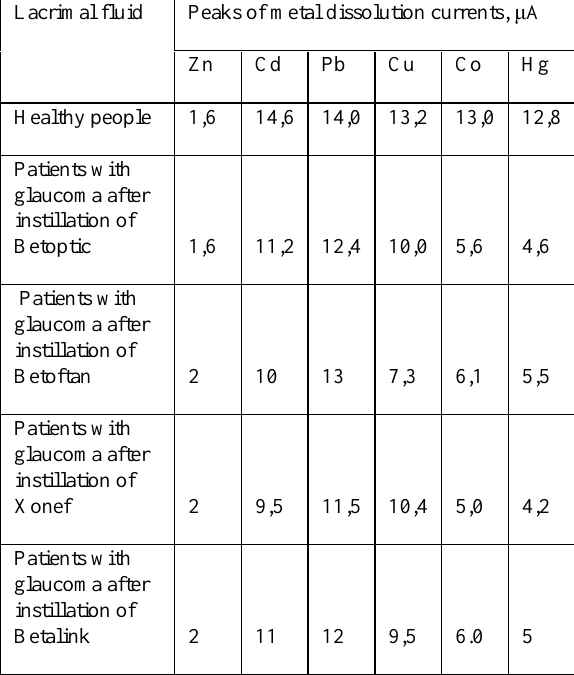
Table 1. The effects of the Betoptic and its generics with the same concentration of the active ingredient on the test system after instillation Lacrimal fluid Peaks of metal dissolution currents,